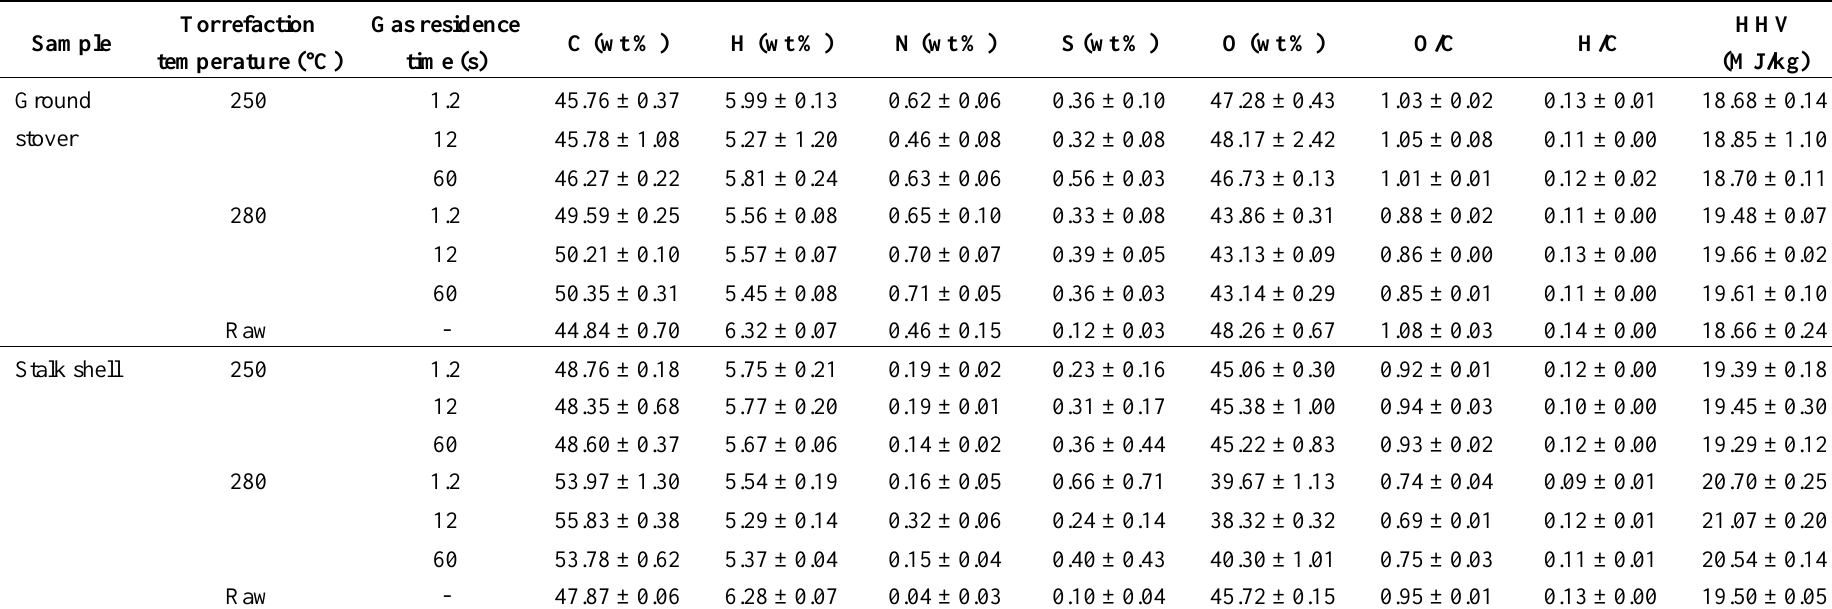
Table 3. Elemental analysis and HHV of biomass